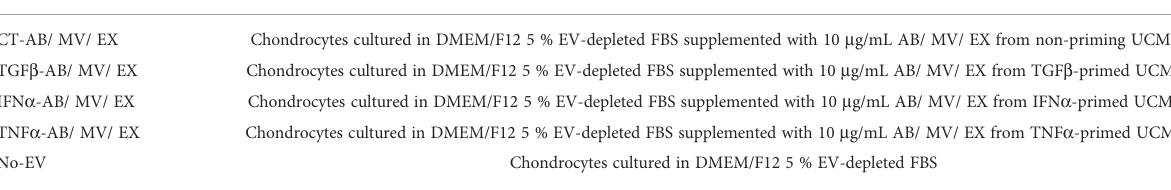
TABLE 1 Experimental settings for chondrocyte functional analysis in vitro . Experimental